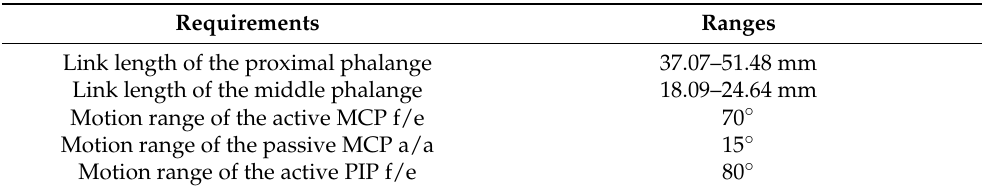
Table 2. The requirements that the robot needs to meet.